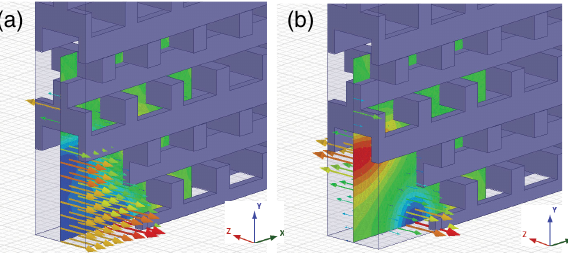
FIG. 6. Two TM-like speed-of-light modes of the original woodpile accelerating waveguide design: (a) the in-phase funda- mental accelerating mode, (b) the out-of-phase spurious mode.